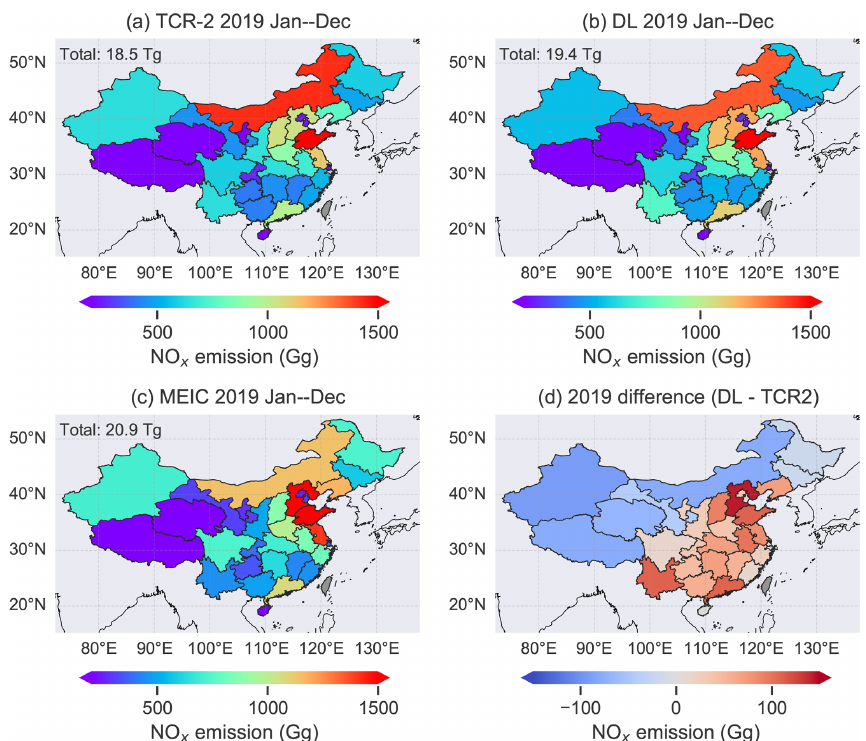
Figure 8. Annual NO x emissions (TgNO) for 2019 estimated by (a) the TCR-2 T106 data product, (b) the DL analysis and (c) the MEIC inventory. The DL minus TCR-2 emission differences are shown in (d) .